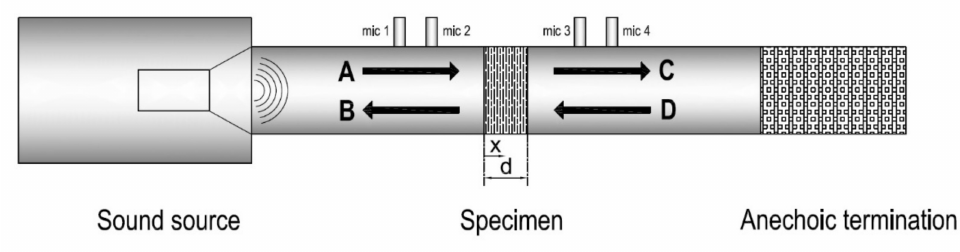
Figure 2. Schematic drawing of a four-microphone impedance